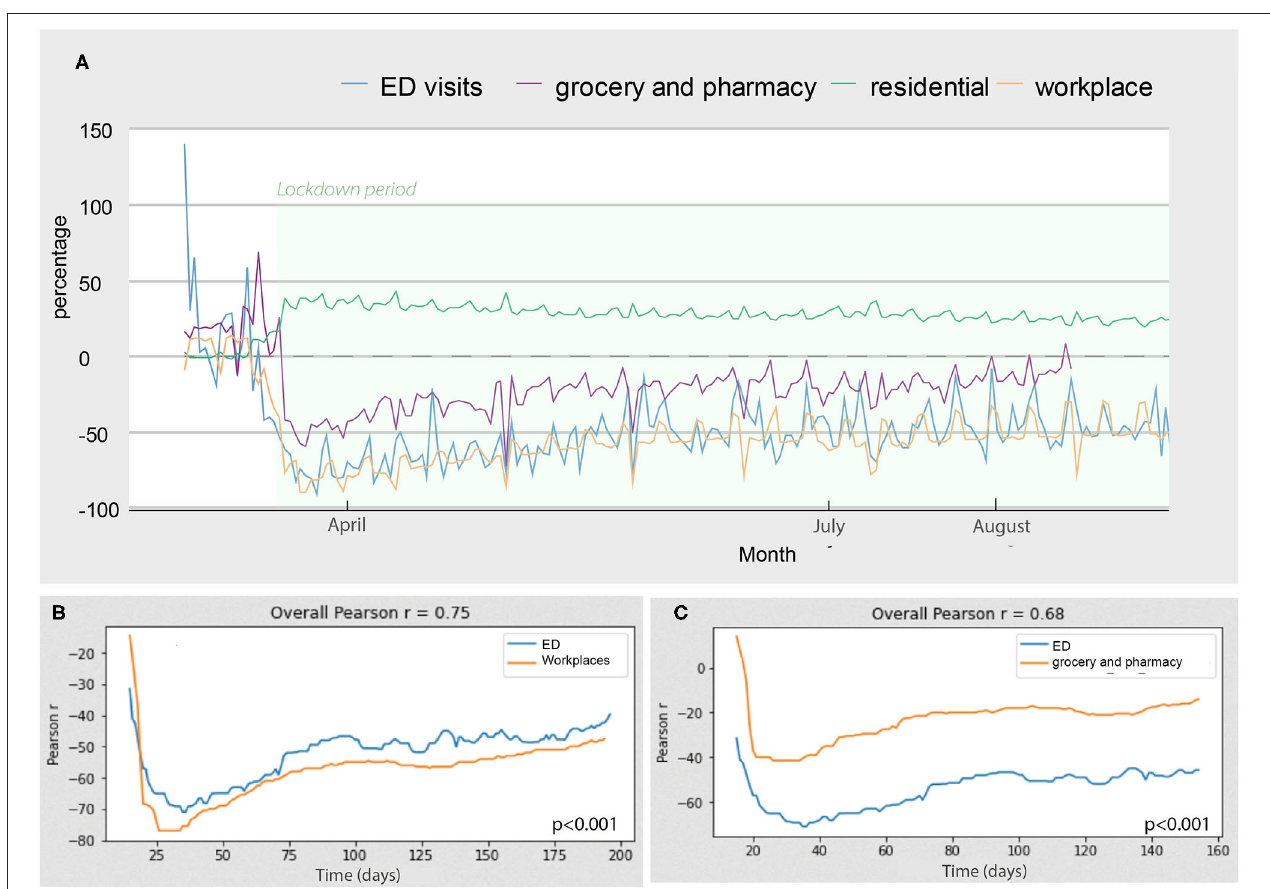
FIGURE 1 | Evolution of the number of ED consults and social mobility. Changes in social mobility and number of ED visits over time. (A) The lines represent the percentage of change compared to the same period of 2019. The correlation plots show the correlation between the number of ED consults and social mobility in workplaces (B) and between the number of ED consults and social mobility in groceries and pharmacies (C)